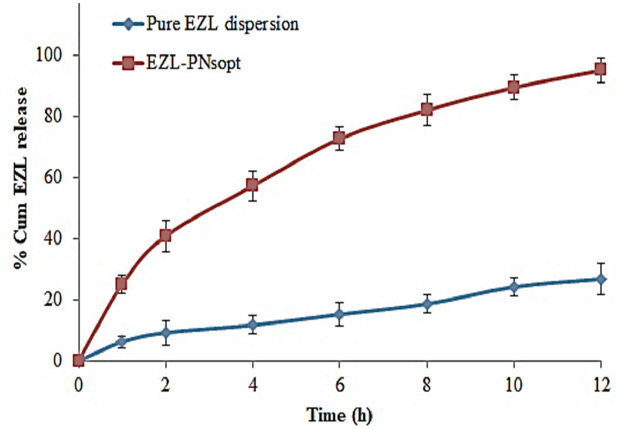
Figure 8. In vitro drug release profile of EZL ‐ PNopt and pure EZL.